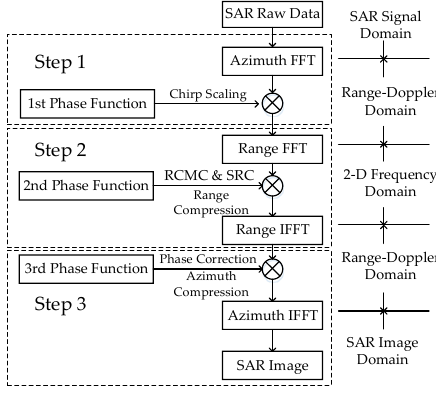
Figure 1. Flowchart of the CS algorithm.